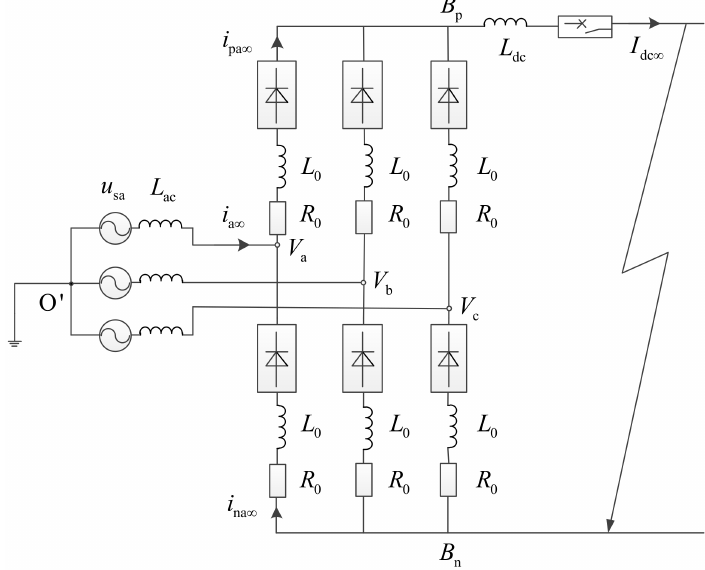
Figure 4. Equivalent circuit of MMC after it is